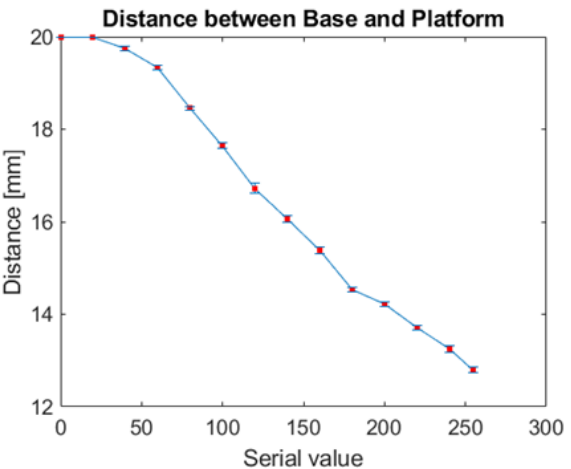
Figure 3. Position behavior of the thimble to the serial port commands sent by the